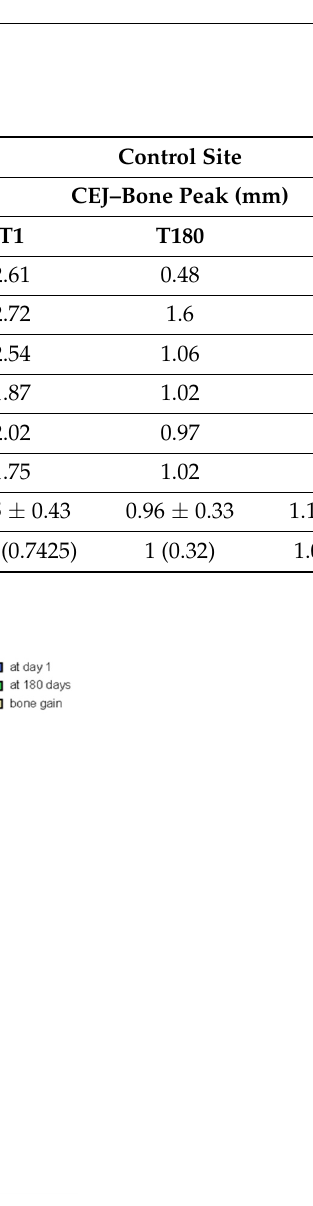
Table 2. Radiographic measurements from distal point of M2’s CEJ to bone peak (mm) at T1 and T180. Bone gain (BG). Mean values of distance in mm.